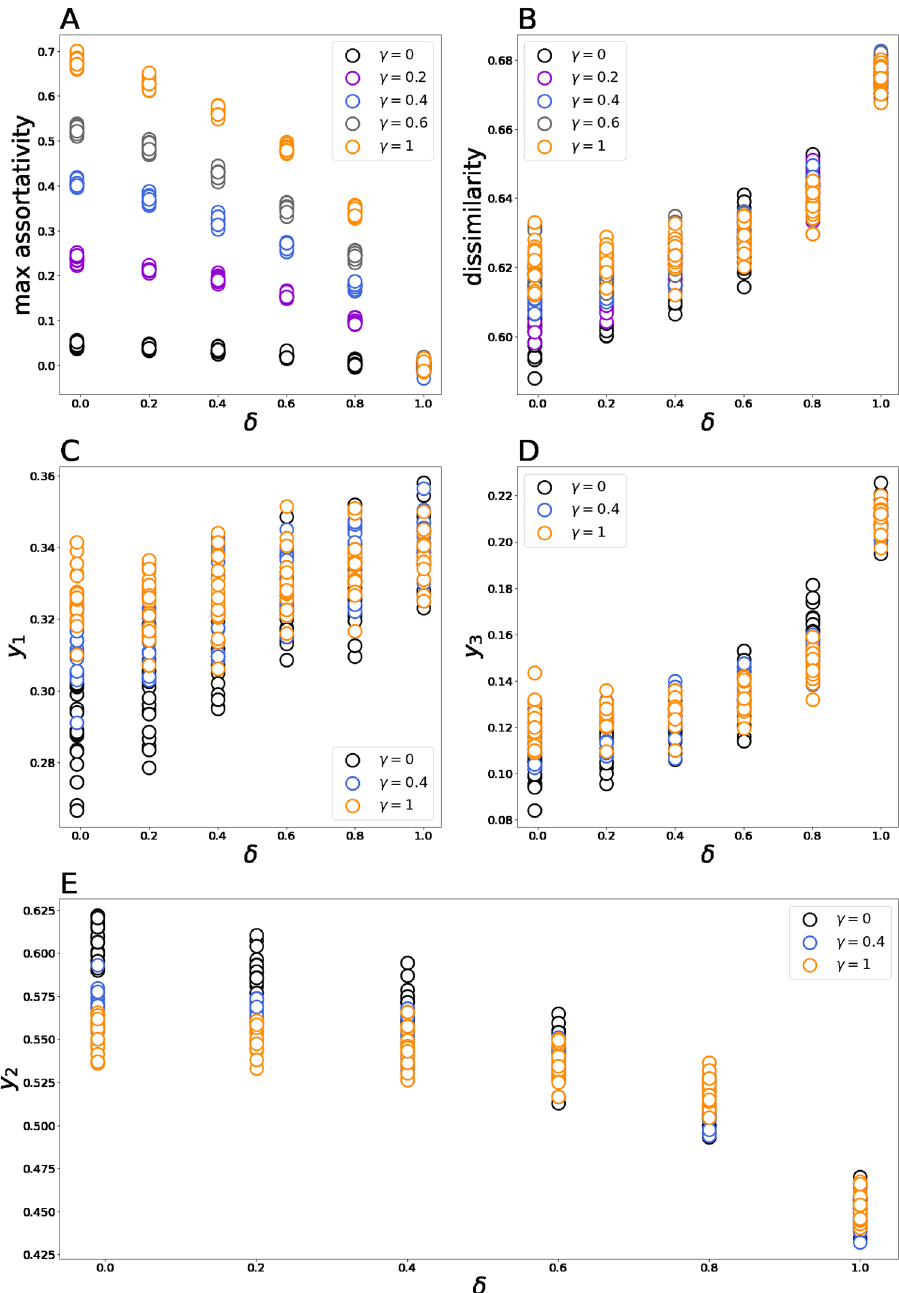
Figure 4. Panels plot how the limiting values of macroscopic metrics M1 – M3 depend on the personalization level ( δ ) and selectivity rate ( γ ). The results presented in this Figure were obtained on random geometric networks in the triple opinion